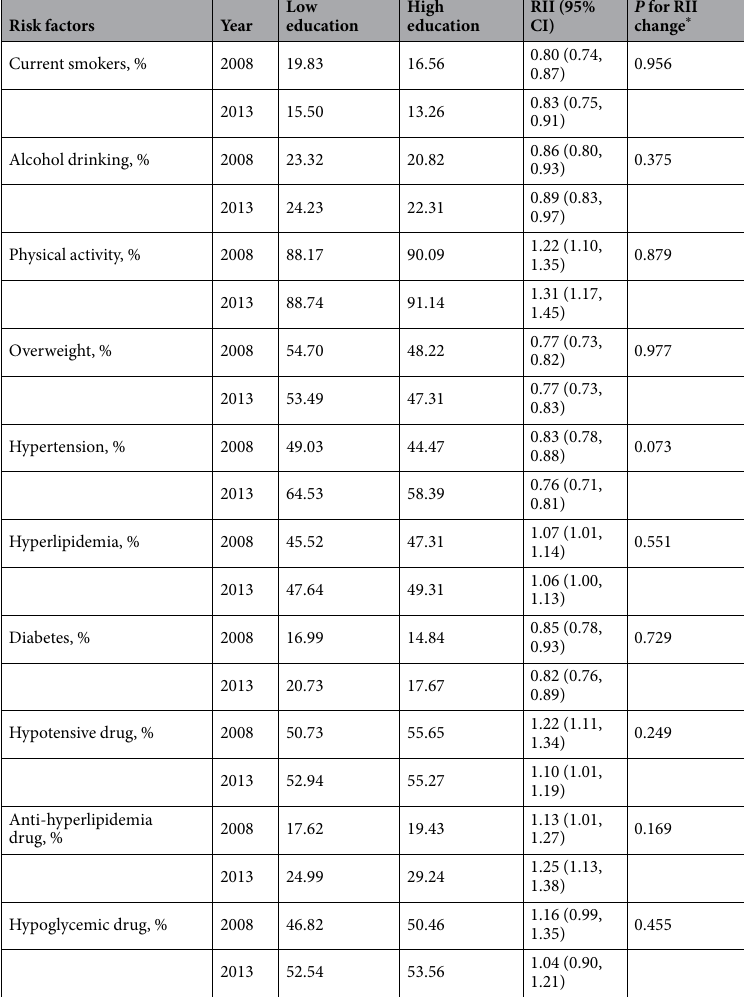
Table 3. Change in coronary heart disease risk factors by educational level, with comparison of RII. Abbreviation: RII, relative index of inequality. Variables were presented as age-standardized prevalence rate. * Test for change in inequality between 2008 and